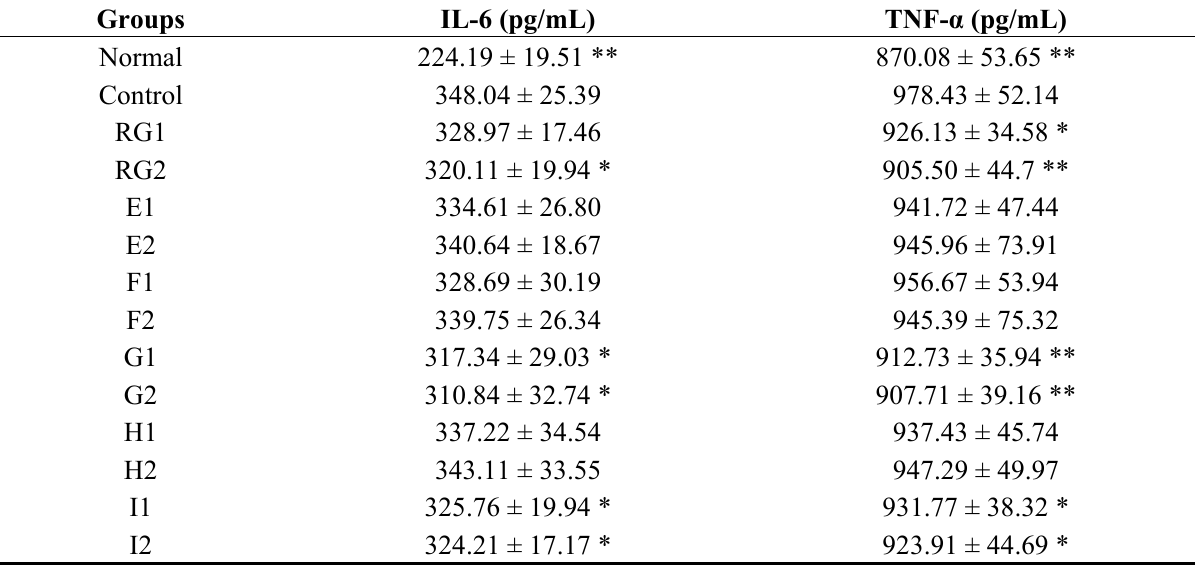
fractions on IL-6 and TNF- α . 1